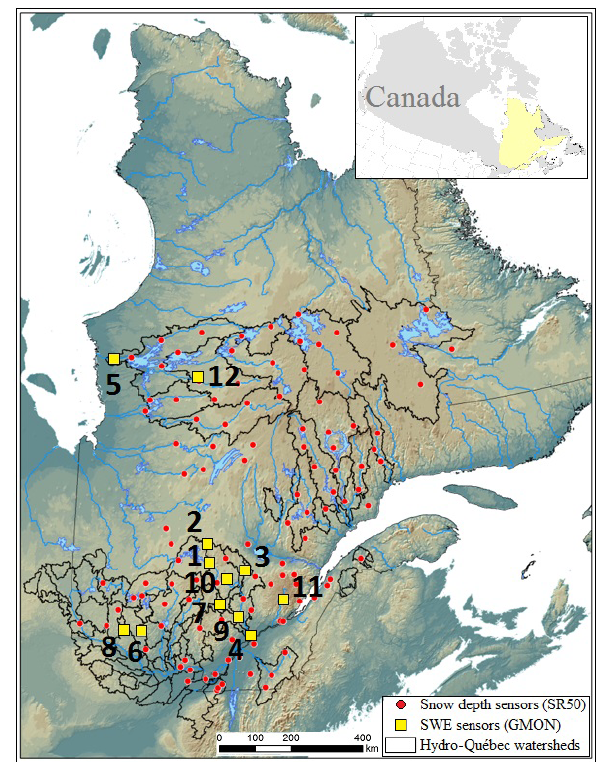
Figure 1. SWE measurement stations with the “GMON” SWE sen- sors (yellow squares; see Table 1 for details) in the province of Que- bec. The red circles are the snow depth sensors (“SR50”) used by Hydro-Québec for hydrological purposes, overlaid on a relief map (from blue – low – to brown – higher altitudes) and watershed con- tours (black